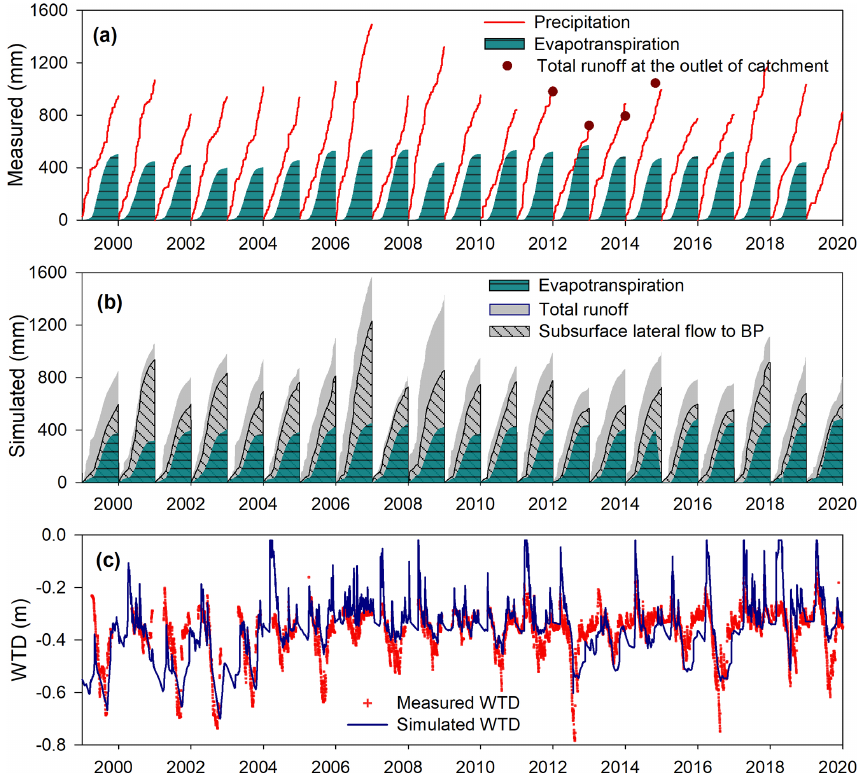
Figure 3. (a) Simulated and (b) measured annual accumulated hydrological components: precipitation, evapotranspiration, total runoff, and the lateral subsurface flow, (c) peatland water table depth, and simulated WTD. The measured evapotranspiration data were from the eddy covariance flux tower. Total runoff measured at the catchment outlet is taken from unpublished data Hutchins